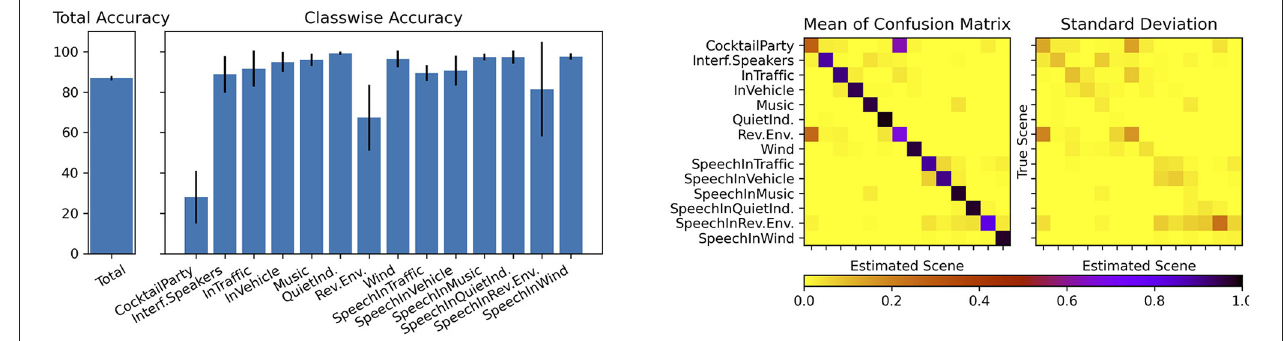
FIGURE 14 | Class wise test accuracies (left) and matrix plots showing mean and standard deviation of the confusion matrix (right)